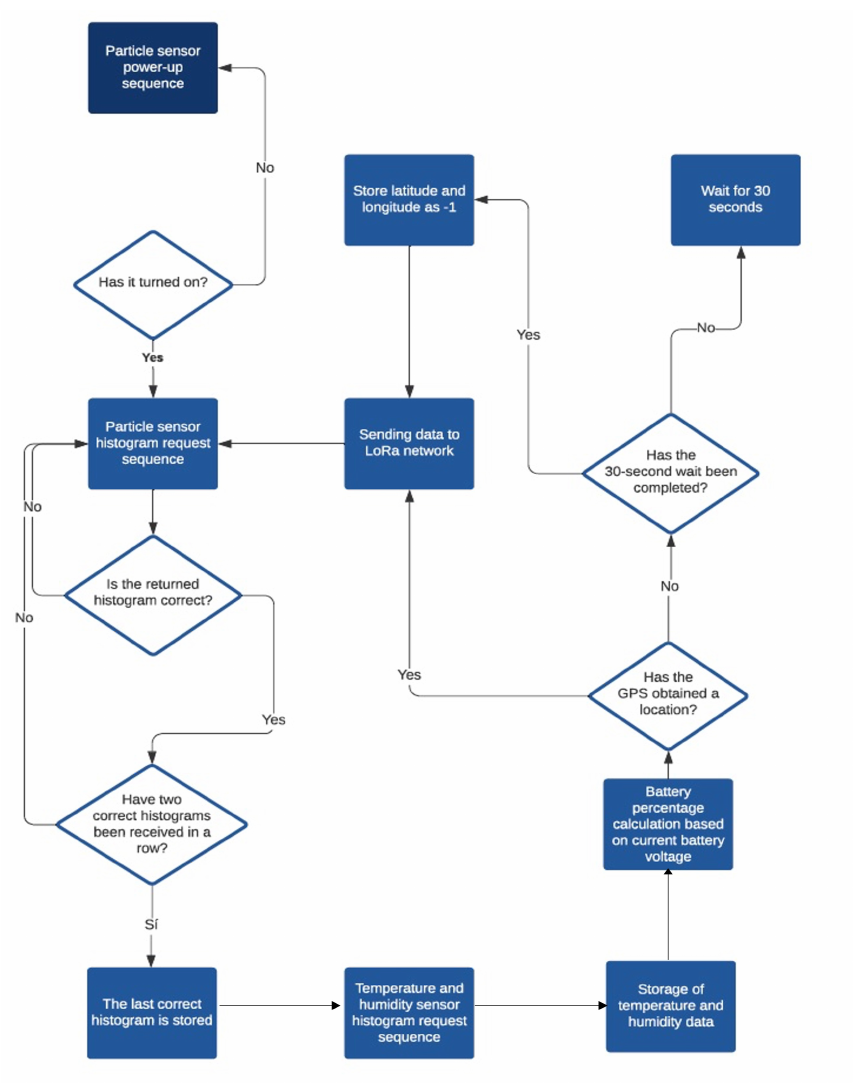
Figure 5. Flow diagram of the operation of the particulate matter measuring